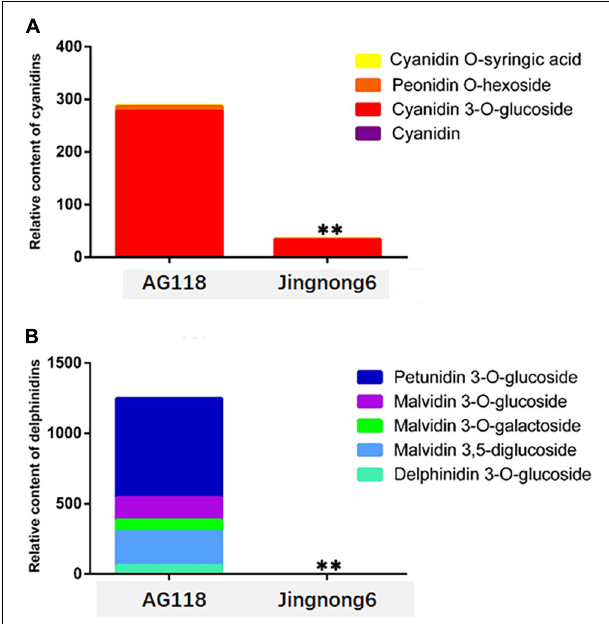
FIGURE 3 | Identification and quantification of the pigments during stage 3 in seed coat colouring of Jingnong6 and AG118. ** P ≤ 0.01